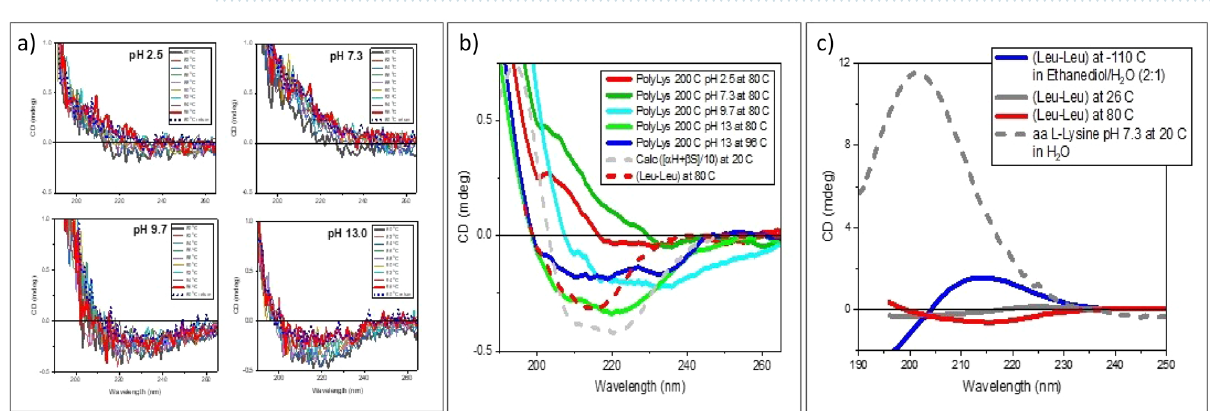
Figure 10. ( a ) CD spectra of HT-200 °C l-lysine in water at four different pHs (2.5, 7.3, 9.7 and 13) as a function of the temperature between 80 and 96 °C (measuring steps, 2 °C in heating and cooling). ( b ) Selected smoothed spectra from the figure a overlapped to a CD spectrum (reduced by 10 folds) of a protein with a secondary structures formed by 16% of α-Helix, 33% β-Strand, 21% Turn, and 30% Unordered. The simulation (grey dashed line) has been performed using a CONTINN algorithm 11,23,24 of B23 CDApps 10 and Leucyl– Leucine (Leu–Leu) (dashed red). ( c ) CD spectra of Leucyl–Leucine in ethanediol/H 2 O (2:1) at − 110 °C (blue), 26 °C (grey) 80 °C (red) and l-lysine at pH 7.3 at 20 °C in H 2 O (dashed grey) 9